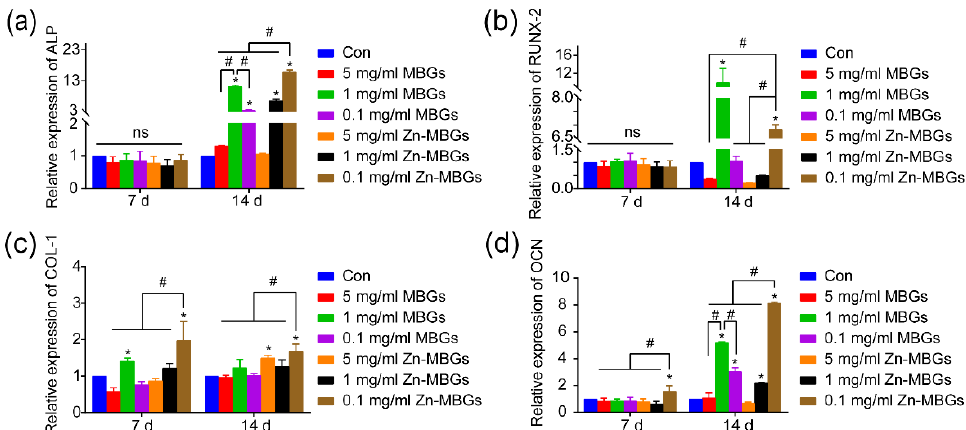
Figure 7. Expression of osteogenic differentiation related genes of BMSCs cultured with different concentrations of MBGs and Zn-MBGs extracts for 7 and 14 days: ALP ( a ), Runx-2 ( b ), Col-1 ( c ), and OCN ( d ). Cells cultured in DMEM were set as the control group. Significant difference between the intervention and control groups (* p < 0.05); significant difference between groups ( # p < 0.05); ns indicates no significant difference.